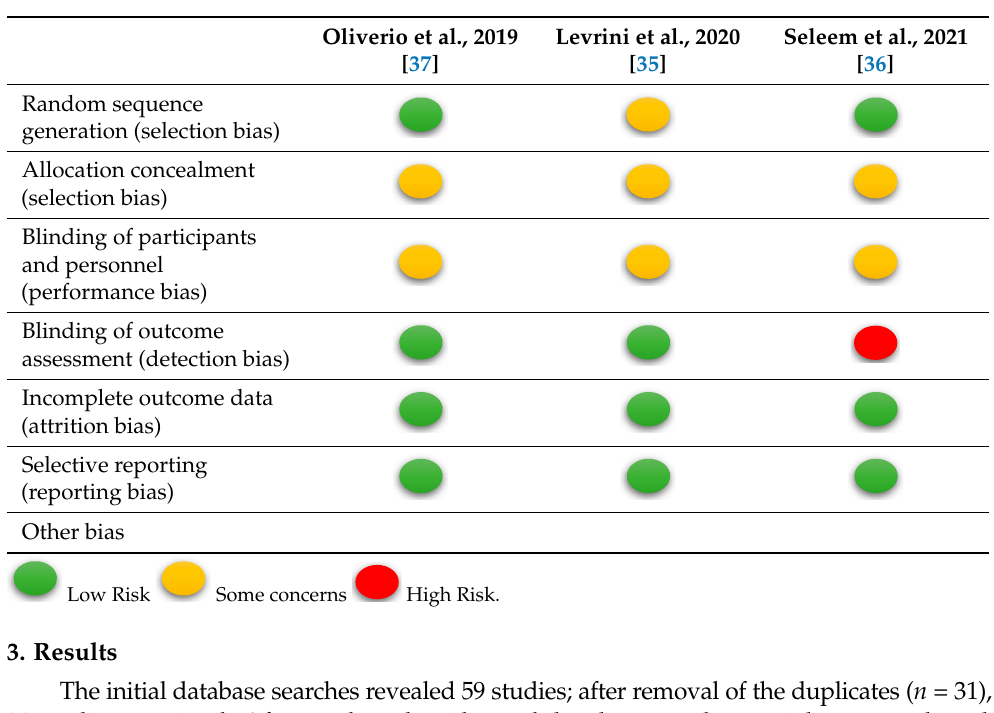
Table 2. Evaluation of the risk of bias in the included studies.